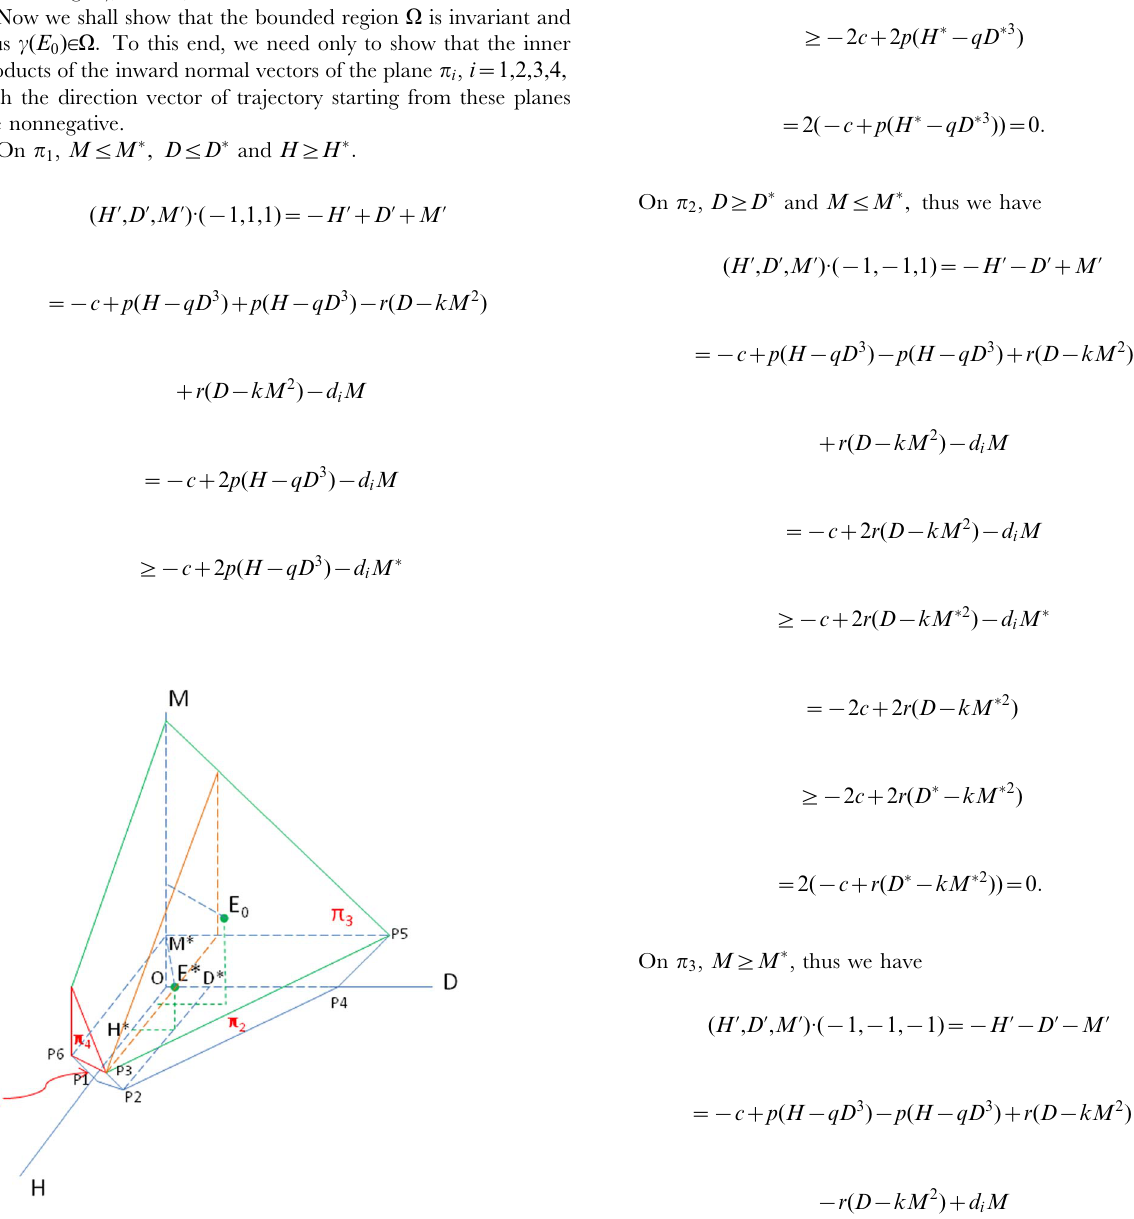
Figure 5. The bounded region V for the proof of Theorem 1.